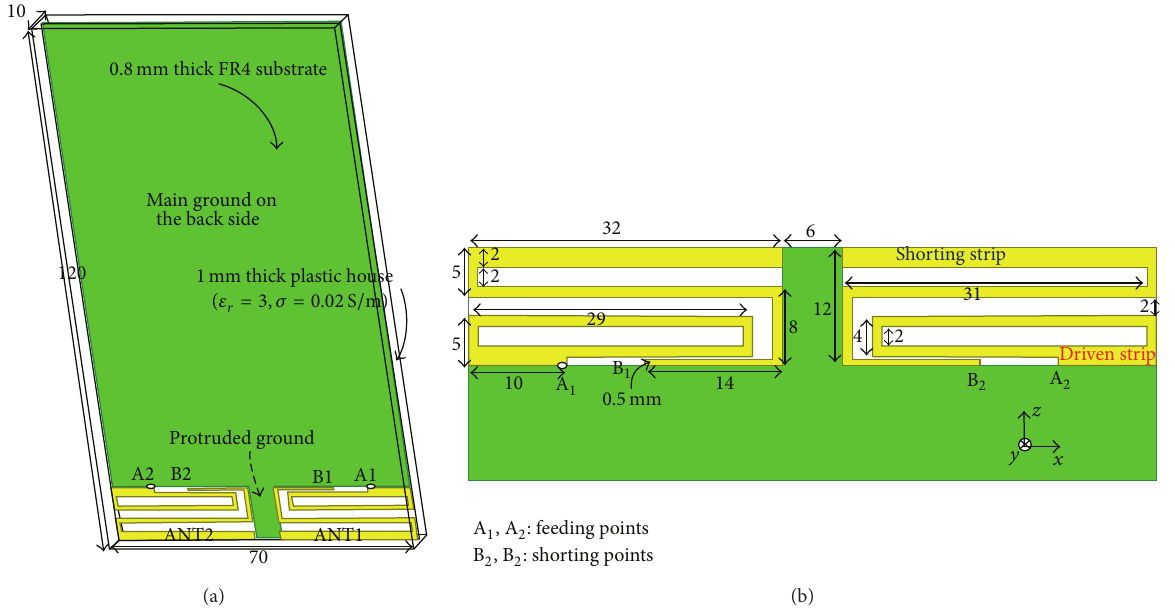
Figure 1: Proposed antenna array configuration. (a) Geometry of the proposed antenna array for mobile phone applications. (b) Detailed dimensions of the proposed antenna array. All dimensions are in